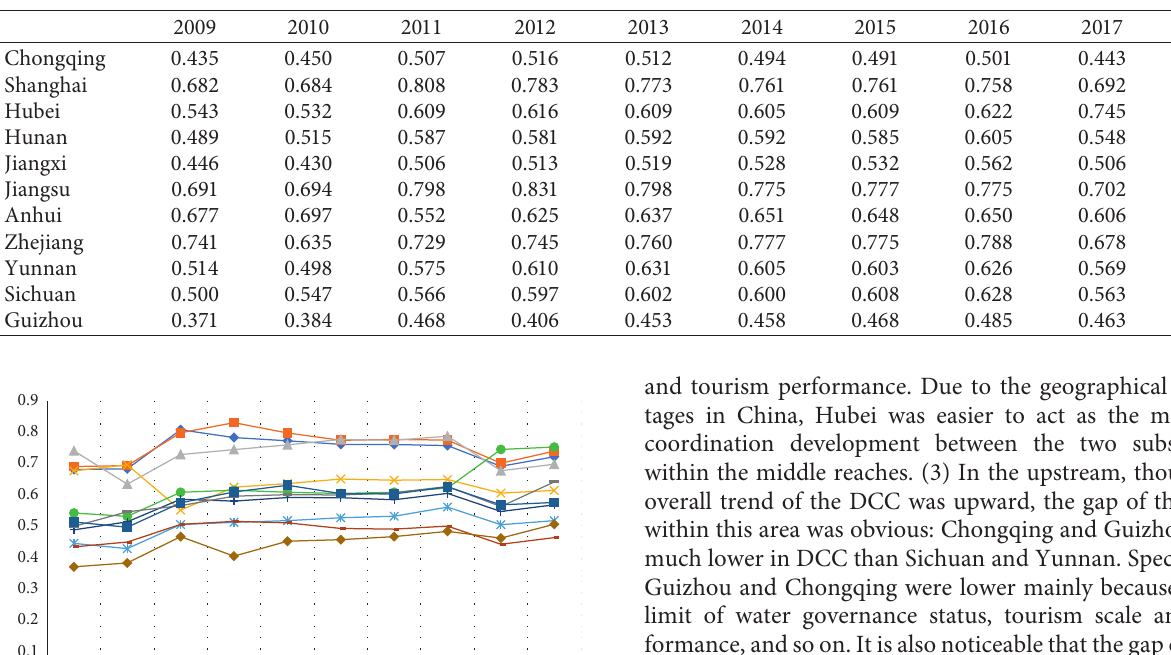
Figure 3: Average DD’s spatial distribution. (a) Water governance subsystem and (b) tourism Table 6: The DCC of the system.